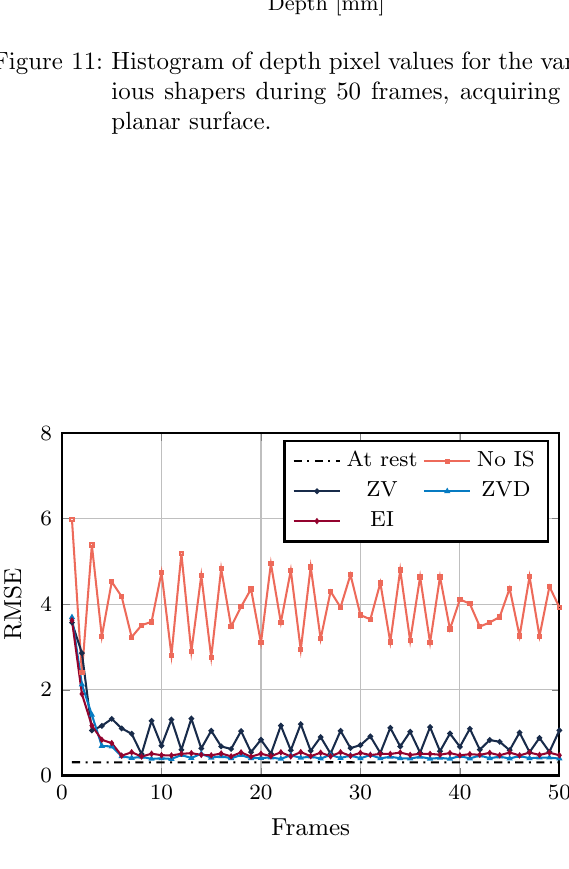
Figure 12: RMSE for the various shapers for the 50 first frames captured after the robot has reached the capturing position following the movement. The RMSE for 50 frames cap- tured when the robot is at rest is given for reference.